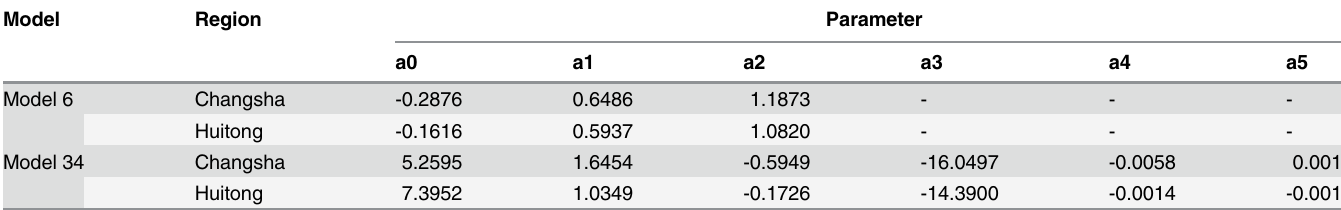
Table 8. Parameter estimates of the two best models in different